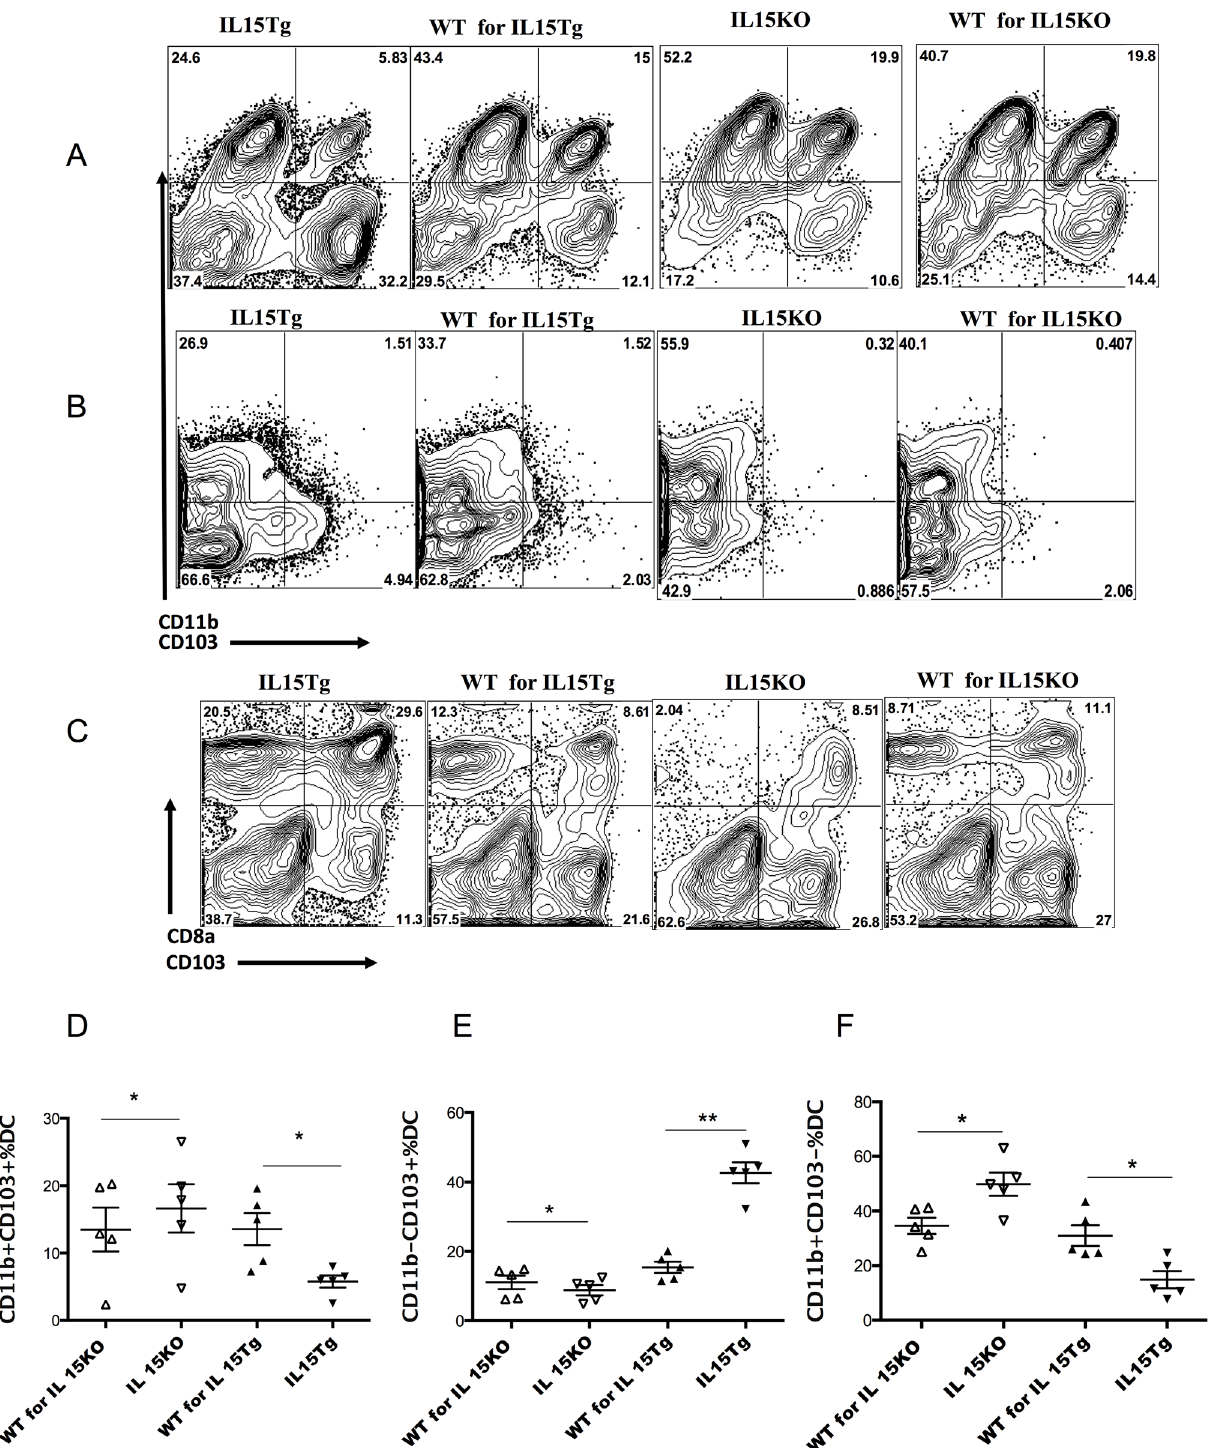
Fig 2. Characterization of MP subsets from intestinal LP and spleen. MPs were purified from small intestinal LP and spleen and then stained for surface markers CD103, CD11b, CD8, and MHCII. A. Purified MPs from intestinal LP were analyzed for CD11b and CD103 expression. One representative mouse was shown. B. Purified MPs from the spleen were analyzed for CD11b and CD103 expression. Far fewer CD103 + MPs were found in the spleen, as expected, but CD103 expression was higher in IL-15 Tg compared to WT mice. Conversely, CD11b expression was slightly lower in IL-15 Tg compared to WT, but slightly higher in the IL-15 KO vs WT. C . MPs purified from LP were analyzed for CD8 α and CD103 expression. FACS plots are representative of five